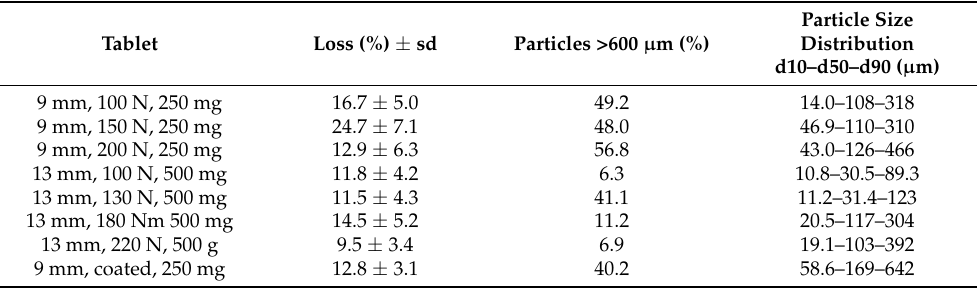
Table 6. Performance of electric grinder IKA. Six tablets were ground one by one, for 3 min, at 25,000 rpm and the obtained powders were pooled for analysis. Percentage loss (mean ± sd, n = 6), particle size fraction >600 µ m, and particle size distribution of the fraction <600 µ m.